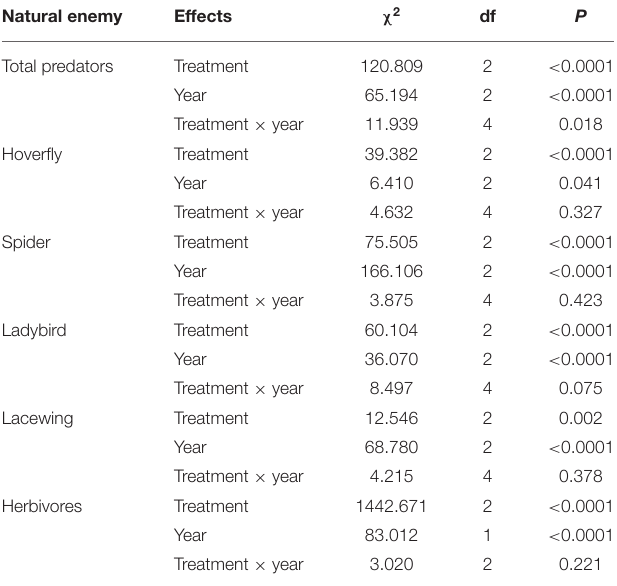
TABLE 2 | Coefficients and statistics of the generalized linear mixed effects models (GLMM) to test for the effect of the cover plant type and year on the abundance of natural enemies and herbivores collected from the sweep